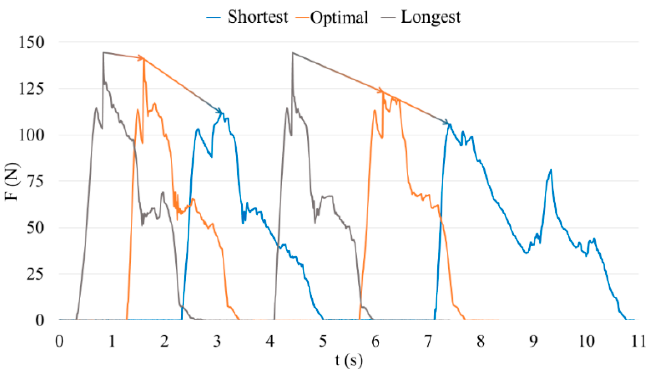
Figure 12. Example of the force applied by one volunteer depending on the distance of the horizontal position (HC: the shortest (HC = 0.75 m), optimal or longest one (HC = 1 m)).